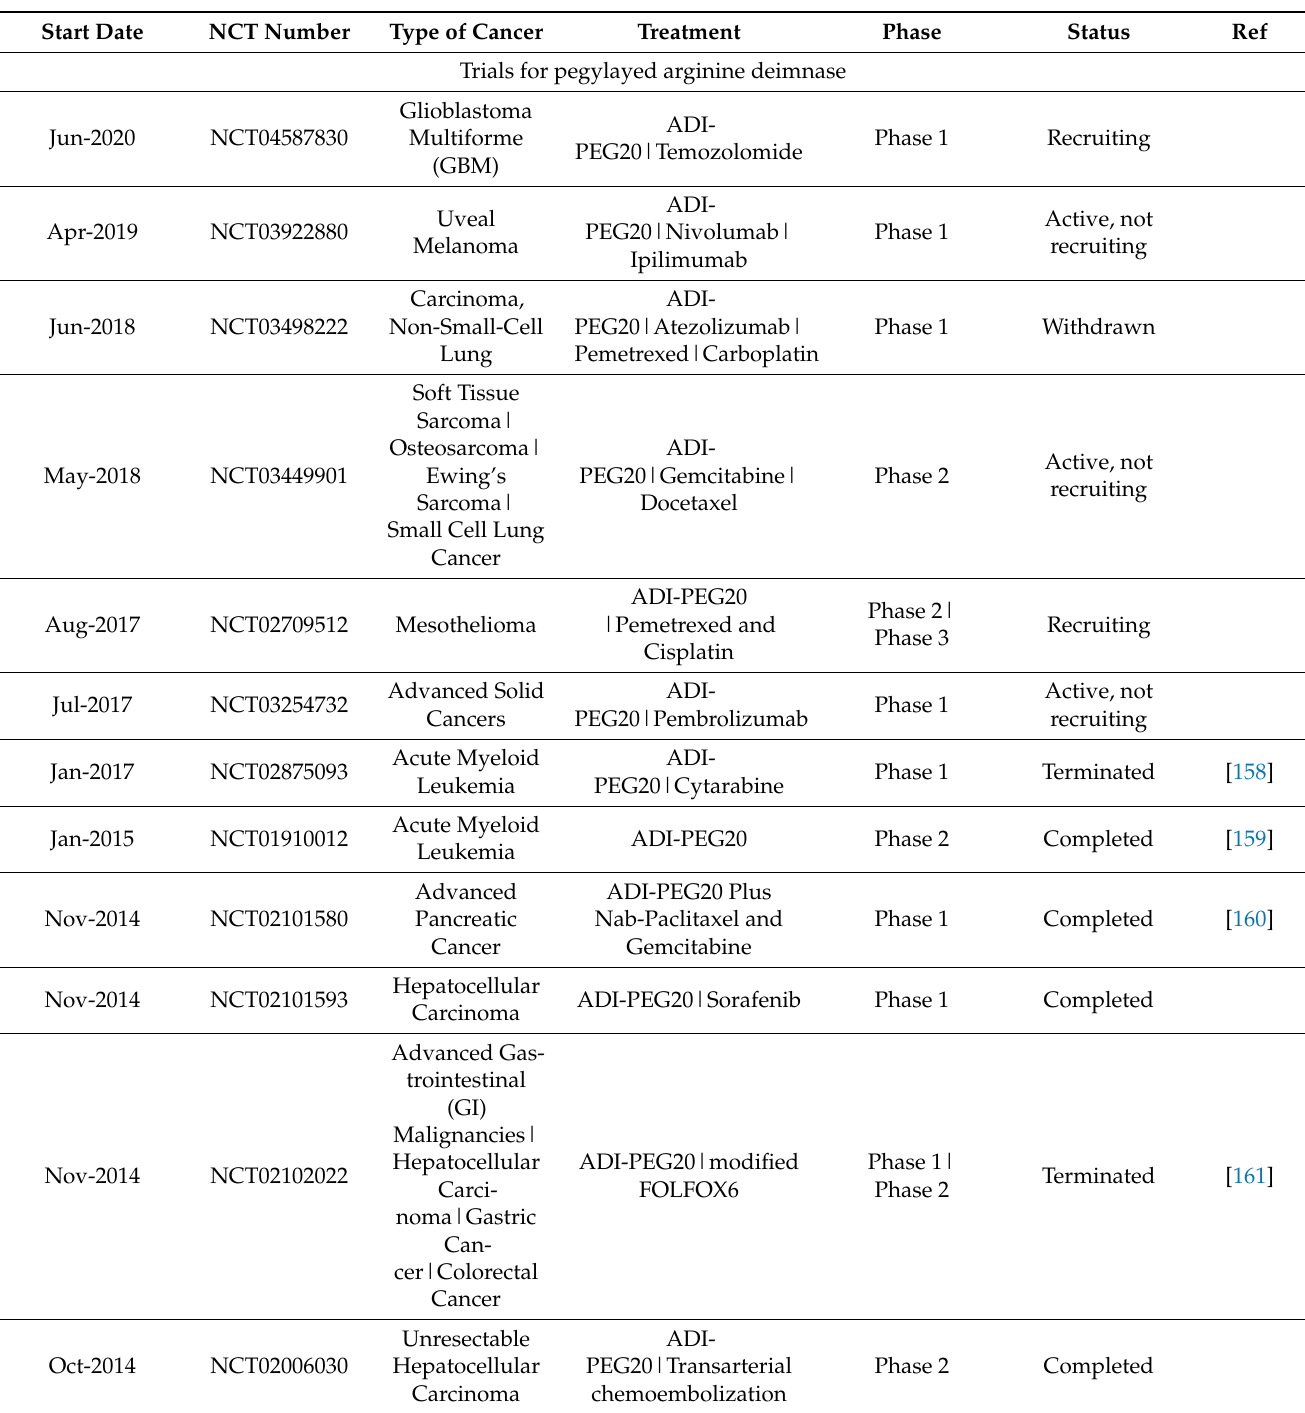
Table 4. Clinical trials for arginine-depletion enzymes and an arginase